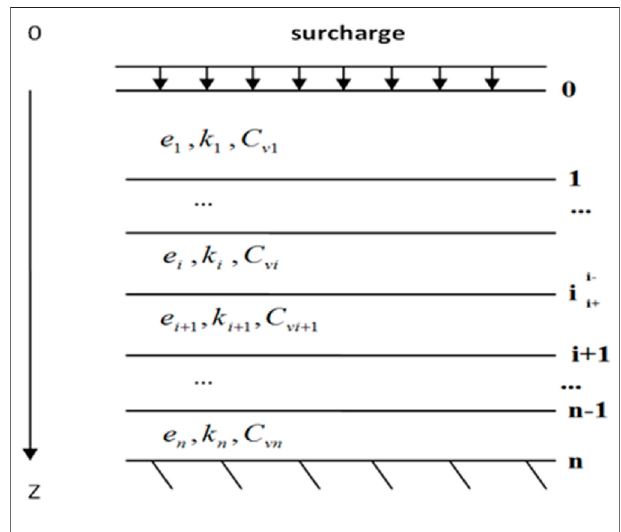
FIGURE 2 | Schematics of multilayer Terzaghi consolidation (positive axis from 0 to z).